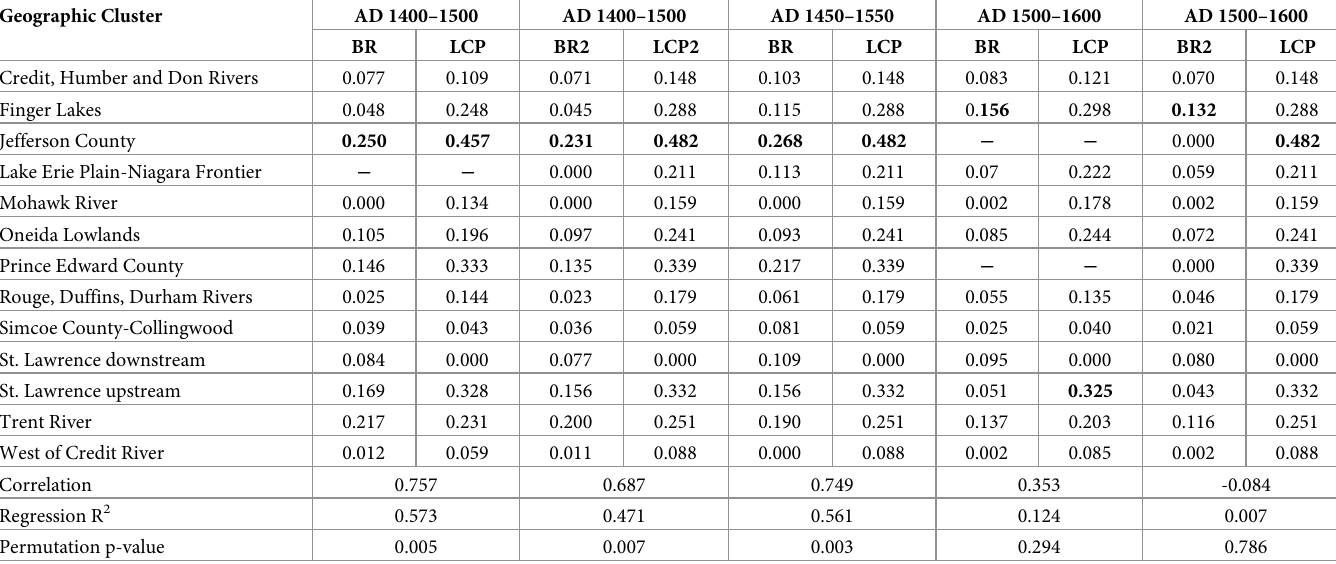
Table 4. Standardized brokerage scores for weighted 100-year average BR and LCP graphs by geographical cluster.